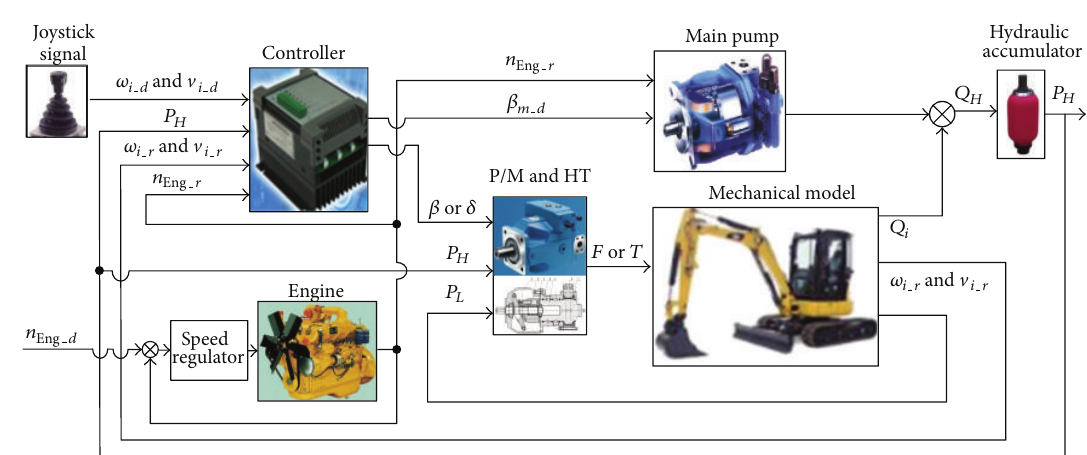
Figure 11: Control principle of HEEC.